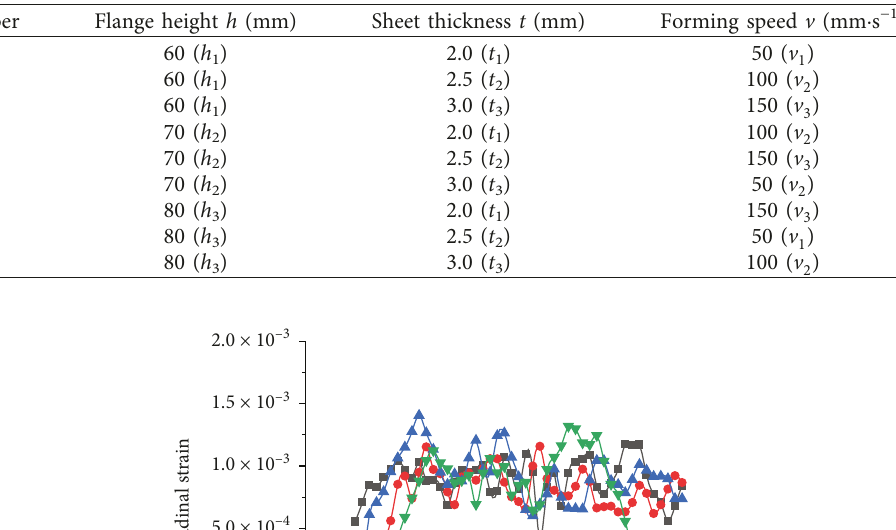
Table 3: Orthogonal experiment results and result analysis.